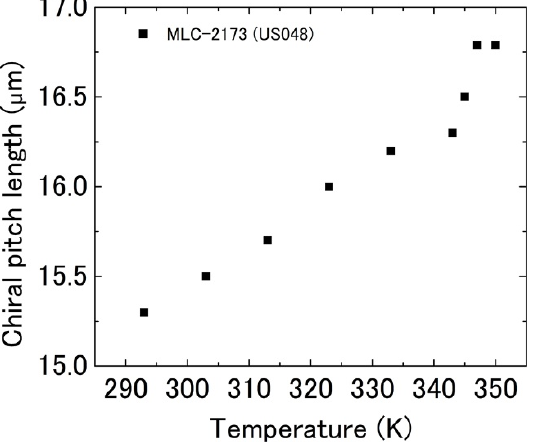
Figure 3. Chiral pitch length as a function of temperature.